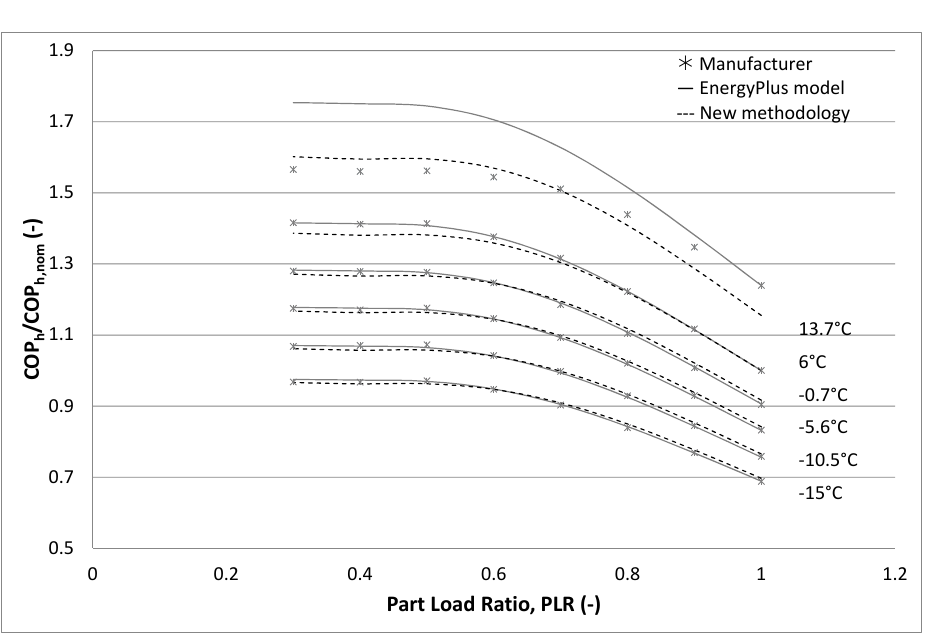
Figure 3. Variation of the heating COP ratio as a function of part load ratio and outdoor dry-bulb temperature (manufacturer and EnergyPlus standard and new model curves).